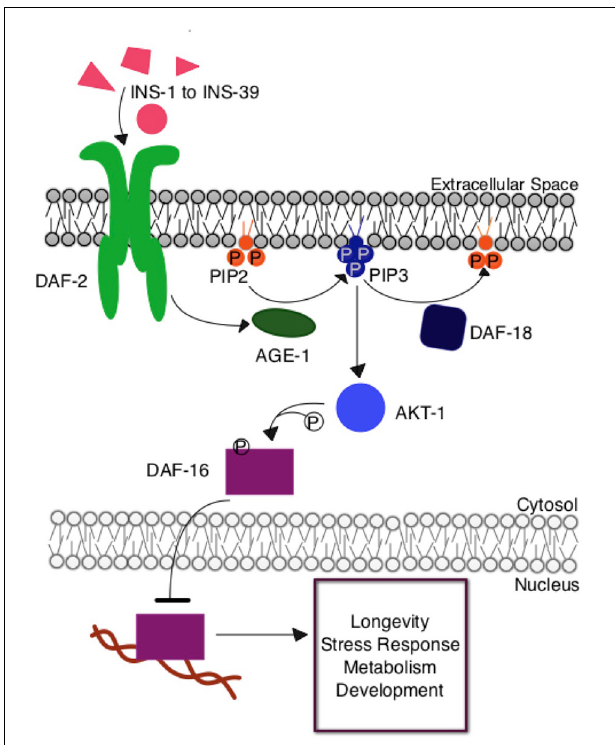
FIGURE 1 | The insulin signaling pathway in Caenorhabditis elegans . Upon insulin ligand binding to the DAF-2 insulin receptor in C. elegans , AGE-1 (homolog to mammalian PI3-K) is activated and converts PIP 2 to PIP 3 at the cellular membrane. PIP 3 activates the central kinase AKT-1 (ortholog to mammalian PKB), which phosphorylates DAF-16, the C. elegans FOXO transcription factor, preventing its entry into the nucleus where it would otherwise regulate the expression of genes contributing to longevity, stress response, and metabolism. The DAF-18 (homolog to mammalian PTEN) phosphatase negatively regulates the system by decreasing the amount of PIP 3 present at the membrane by reconverting it to PIP 2